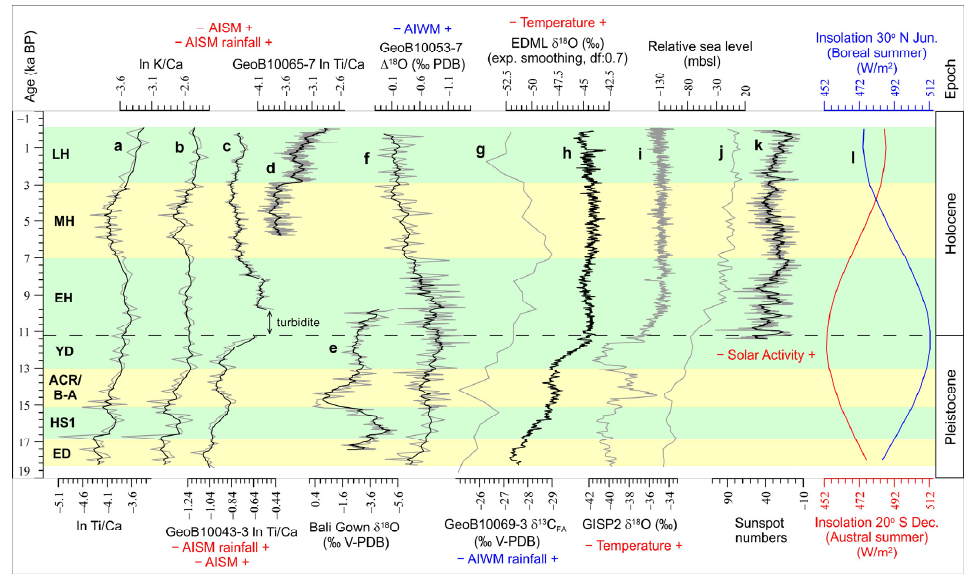
Figure 7. Drier (yellow highlight) and wetter (green highlight) periods inferred from terrigenous input proxies ( a , b ). Other paleoclimate records are presented for comparison: ( c ). Terrigenous input proxy (ln Ti/Ca) record of GeoB10043-3 [10], ( d ). Terrigenous input proxy (ln Ti/Ca) record of GeoB10065-7 [2], ( e ). δ 18 O record of stalagmites from Bali Gown cave (Northwestern Australia) [14], ( f ). δ 18 O Globigerinides ( Gs. ) ruber – δ 18 O Globigerina ( G. ) bulloides ( Δ 18 O) record of GeoB10053-7 [1], ( g ). C 30 n -alkanoic fatty acids δ 13 C ( δ 13 C FA ) record of GeoB10069-3 [28], ( h ). δ 18 O record of Antarctic